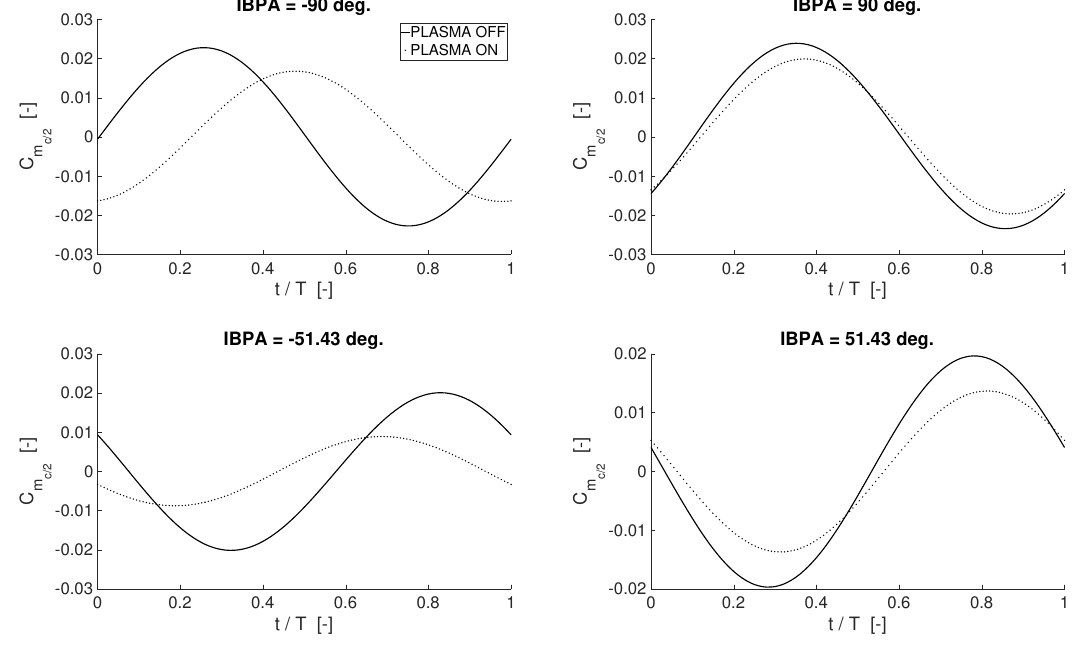
Figure 15. Time history of the mid-chord pitching moment coefficient C m last simulated period; Re ∼ 195,000; α = 2 + sin ( 2 π f t + 4 × IBPA π IBPA = [ ± 90, ± 51.43 ]